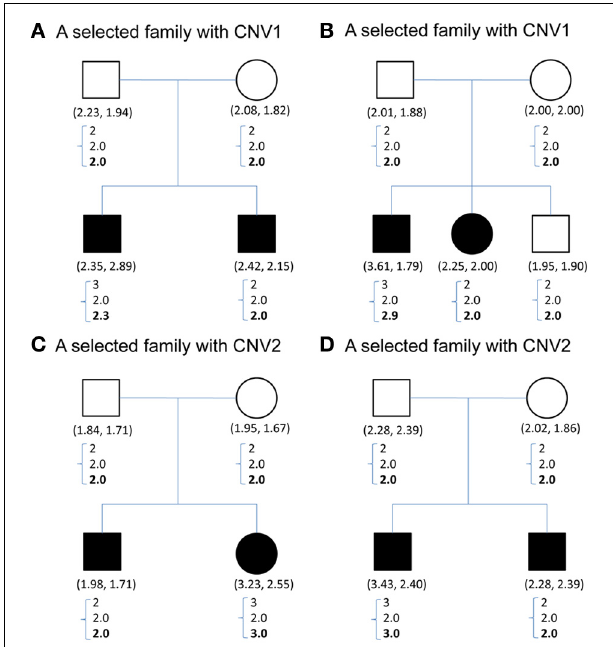
FIGURE 1 | (A–D) Contain CNV information for four sample families selected from TSLS. Solid symbols indicate schizophrenia sufferers. Below each symbol, the two numbers in parentheses show the replicate CNV measures. Below the parentheses, there is a column of three numbers. The first one represents the predicted value, the closest integer to the average of the replicate CNV measures; the second represents the posterior mean of the latent copy number under the model without mutation parameters; and the third number in boldface represents the posterior mean of the latent copy number under the model with mutation parameters. (A,B) Contain the CNV1 information, and (C,D) are for